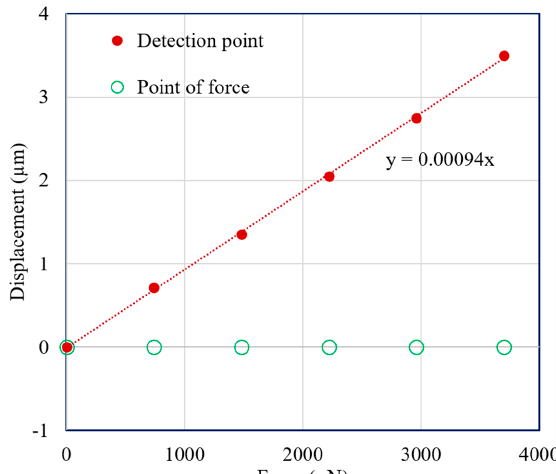
Figure 12. Displacements of the point of force and detection point with the addition of a unit force of 740 µ N.